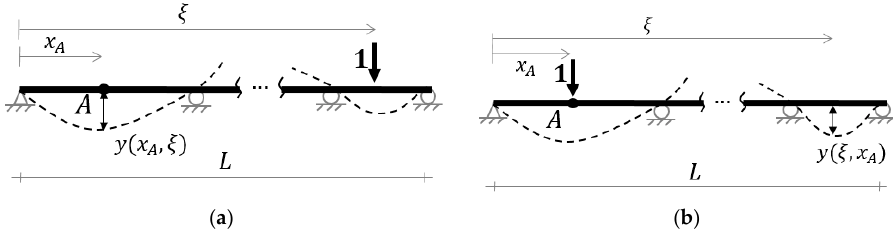
Figure 1. Initial position and deflected shape of a beam structure under the effects of a unit load located at ( a ) ξ ; ( b ) x A